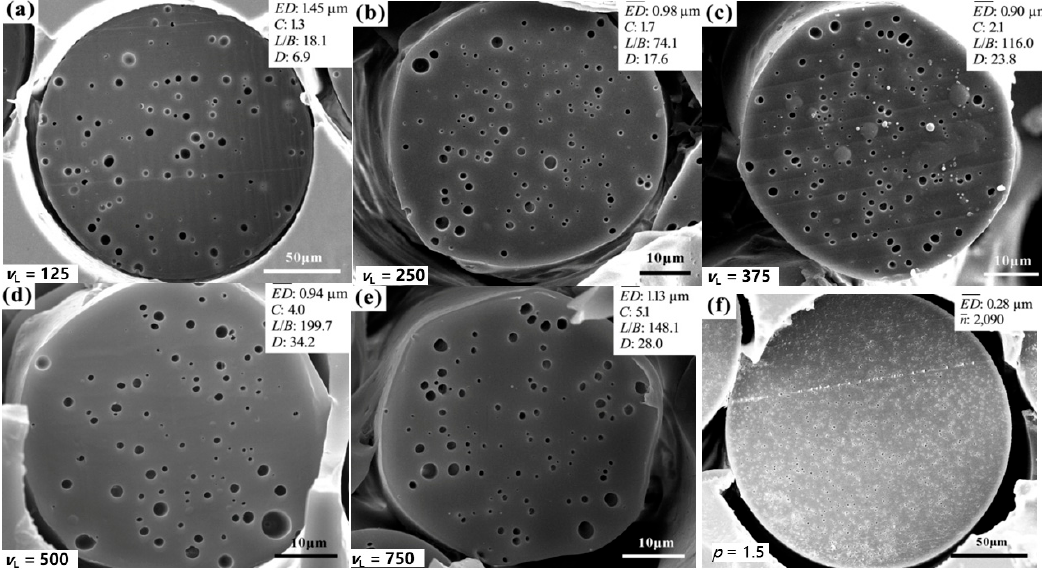
Figure 7. SEM micrographs of PP/PS take-up fibers at various velocities; ( a ) 125, ( b ) 250, ( c ) 375, ( d ) 500, and ( e ) 750. The zero-shear viscosity ratio of PS/PP is 10.8 for all samples from (a)–(e). ( f ) SEM micrographs of the extrudate fiber with a viscosity ratio of 1.5. The weight percent of the PS phase in blend fiber is 8% for all cases [64]. Reproduced with permission from He, H.; Chen, L.; Sun, S.; Wang, T.; Zhang, Y.; Zhu, M., Fibers and Polymers; published by Springer Nature, 2014.